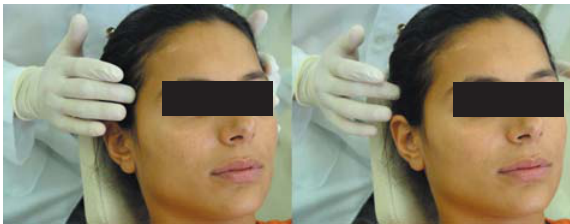
FIGURE 1- Measurement of maximum active opening and maximum lateral movement